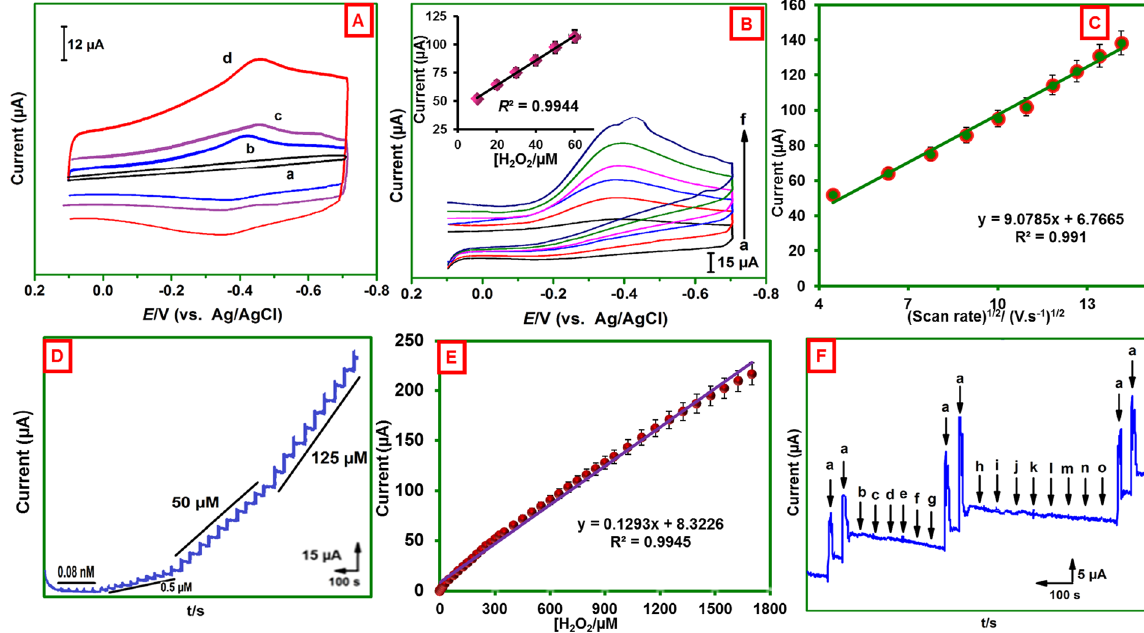
Figure 4. ( A ) CVs obtained at CHIT/Mb/GCE (a), MWCNTs@rGONRs/Mb/GCE (b), MWCNTs/CHIT/ Mb/GCE (c), and MWCNTs@rGONRs/CHIT/Mb/GCE (d) in phosphate buffer (pH 7) containing 10 µ M H 2 O 2 . Scan rate = 50 mV s − 1 . ( B ) CVs of GCE/MWCNTs@rGONRs/CHIT/Mb in phosphate buffer (pH 7.0) containing different concentrations of H 2 O 2 (a = 10, b = 20, c = 30, d = 40, e = 50 and f = 60 µ M). Inset: [peak current] vs. [H 2 O 2 ]/ µ M. ( C ) [scan rate] 1/2 /(V.s − 1 ) 1/2 vs. [current]/ µ A. CVs obtained in phosphate buffer (pH 7.0) containing 10 µ M H 2 O 2 at different scan rates. ( D ) Amperometric response of GCE/MWCNTs@rGONRs/ CHIT/Mb for different concentrations of H 2 O 2 . Rotation speed = 1200 rpm; E app = − 0.35 V. ( E ) calibration plot: [H 2 O 2 ] ( µ M) vs. response current ( µ A). ( F ) Amperometric response of MWCNTs@rGONRs/CHIT/Mb for 10 µ M H 2 O 2 (a) and other species (10 µ M of dopamine (b), uric acid (c), ascorbic acid (d), NADH (e), folic acid (f), cysteine (g), epinephrine (h), guanine (i), pyridoxine (j), cholesterol (k), caffeine (l), methionine (m), glucose (n) and nitrate